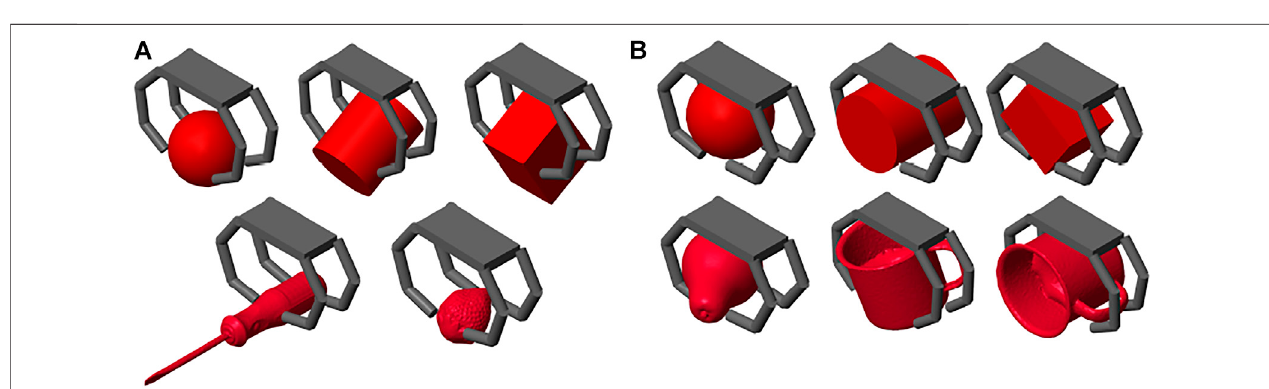
FIGURE 6 | Performed simulations. (A) Precision grasps. (B) Power